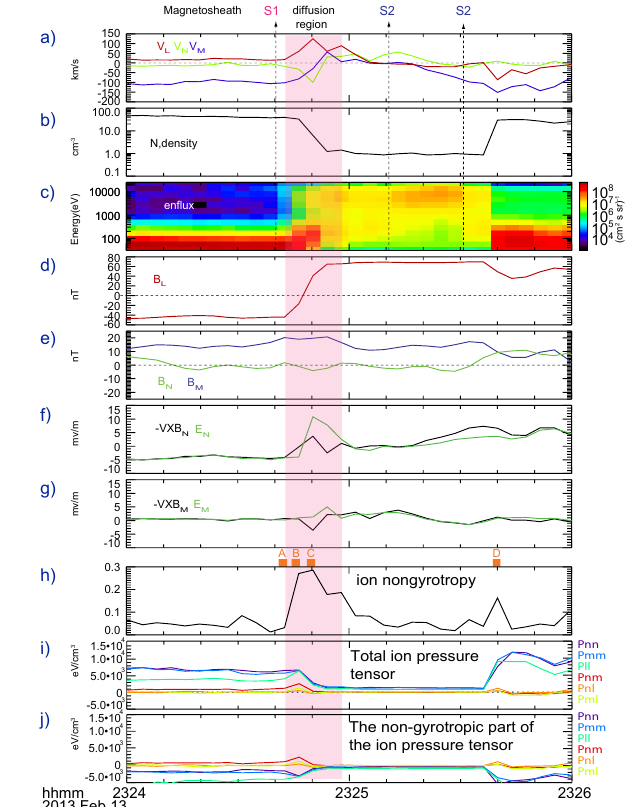
Figure 2. Observations by THEMIS spacecraft E in the ion diffu- sion region. All THEMIS data in Fig. 2 are of spin resolution and at the cadence of the particle instrument. Panel (a) : three compo- nents of the proton flow velocity in the LMN coordinate system, showing a flow reversal in the L (north–south direction). Panel (b) : the plasmas density. Panel (c) : the electron differential energy flux. Panels (d) and (e) : three component of magnetic field in the LMN coordinate. Panels (f) and (g) : the comparison of v i × B with the electric fields in N and M , respectively. Three-dimensional electric fields are obtained from the E · B = 0 assumption. Panel (h) : the ion non-gyrotropy index (Aunai et al., 2013), characterizing the degree of non-gyrotropy in the distribution function. The ion velocity dis- tribution function in intervals marked by A, B, C and D are show in Fig. 3. Panel (i) : components of the ion pressure tensor in the boundary normal coordinate. Panel (j) : the non-gyrotropic part of the ion pressure